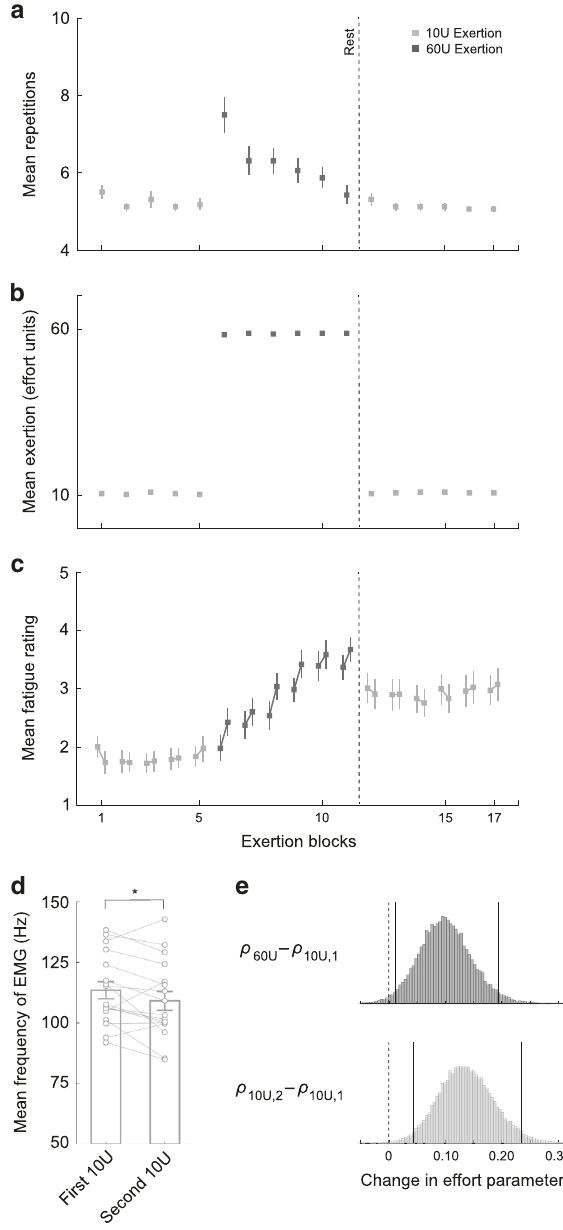
Fig. 6 Results from Control Experiment 2 (Control Experiment 2; n = 17). a Exertion trial performance during the modi fi ed fatigue choice phase. Performance is represented as the mean repetitions required to successfully perform fi ve exertions (successful trials need not be consecutive); higher values indicate more exertion trials were required in order to successfully exert at the target effort fi ve times. Error bars indicate SEM. b Mean exertion during the modi fi ed fatigue choice phase. Mean exertion is presented in units of effort. Error bars indicate SEM. c Self- reported measures of participants ’ state of fatigue over the course of the modi fi ed fatigued choice phase. The plot shows mean self-reported ratings of fatigue at the beginning and end of the 17 exertion blocks. Self-reported fatigue persisted when the exertion task returned to low effort trials after a two minute rest. Error bars indicate SEM. d Mean frequency of the power spectrum of EMGs between fi rst and second low effort sections of the modi fi ed fatigue choice phase. The plot shows mean frequency measures from EMGs for all successful exertions averaged within the fi rst and second low effort (10U) sections. Mean frequency of the EMG power spectrum decreased between fi rst and second low effort sections (average change in mean frequency: − 4.39 Hz; two-tailed paired-sample t -test: t 16 = − 2.25, p = 0.04). Error bars indicate SEM. * p = 0.04. e Histograms of the parameter-space posteriors from the hierarchical Bayesian model estimating changes in effort subjectivity parameters ( Δ ρ ) between the different sections of the modi fi ed fatigue choice phase. The population exhibited an increase in effort subjectivity parameters ( ρ ) during choices intermixed with high effort exertions, as compared to the fi rst session of 10U low effort exertions (60U; ρ 60 U – ρ 10 U ,1 ; dark gray). This shift in effort subjectivity remained even after returning to low effort exertions (10U; ρ – ρ 10 U ,2 10 U ,1 ; light gray). The solid black lines indicate the bounds of the 95% highest-density interval for each distribution, both of which exclude 0 (indicated with the dashed black